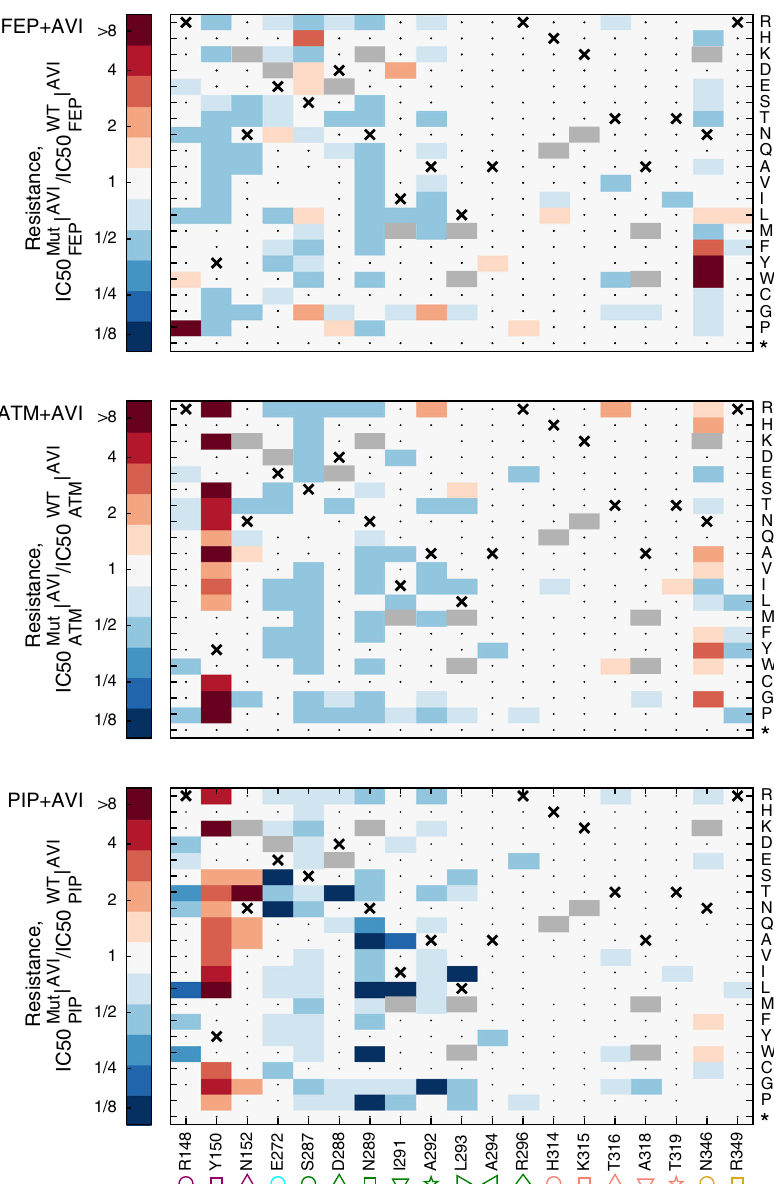
Fig. 4 The resistance of all mutants to PIP, ATM, and FEP when co-applied with AVI as calculated from high-throughput sequencing data. The relative resistance of all identi fi ed mutants to the beta-lactam drugs when supplemented with 0.25 μ g/ml avibactam calculated as the drug concentration that j AVI , divided by that of the WT IC 50 WT j AVI . The WT amino acid is marked with an X and mutations, which were not inhibits mutant growth, IC 50 Mut AB AB included in our design are marked in gray. Mutations which did not confer resistance to any drug were not enriched and could not be identi fi ed in our data are marked with a dot. Source data are provided as a Source Data fi